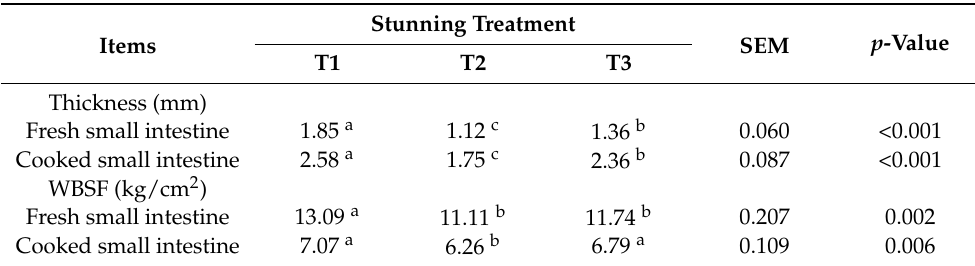
Table 4. Effect of electric and gas stunning (CO 2 -80% and N 2 -98%) on thickness and WBSF of pigs small intestine (both fresh and cooked) ( n =